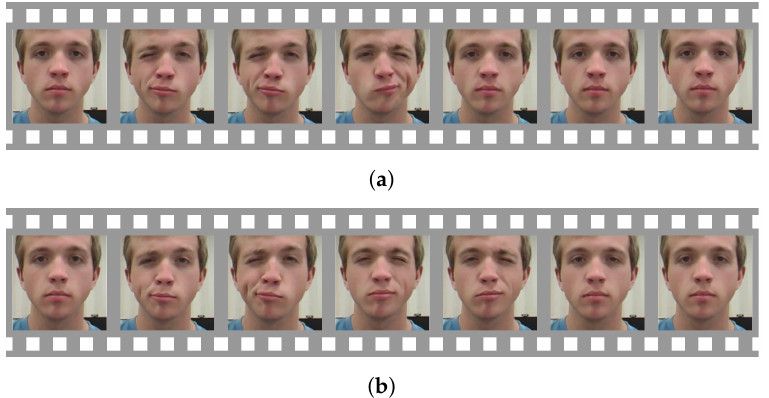
Figure 7. False negative example with slightly different facial motion intensity. ( a , b ) are both the motion pouting lips from right to left, but ( a ) has higher intensity when turning left.